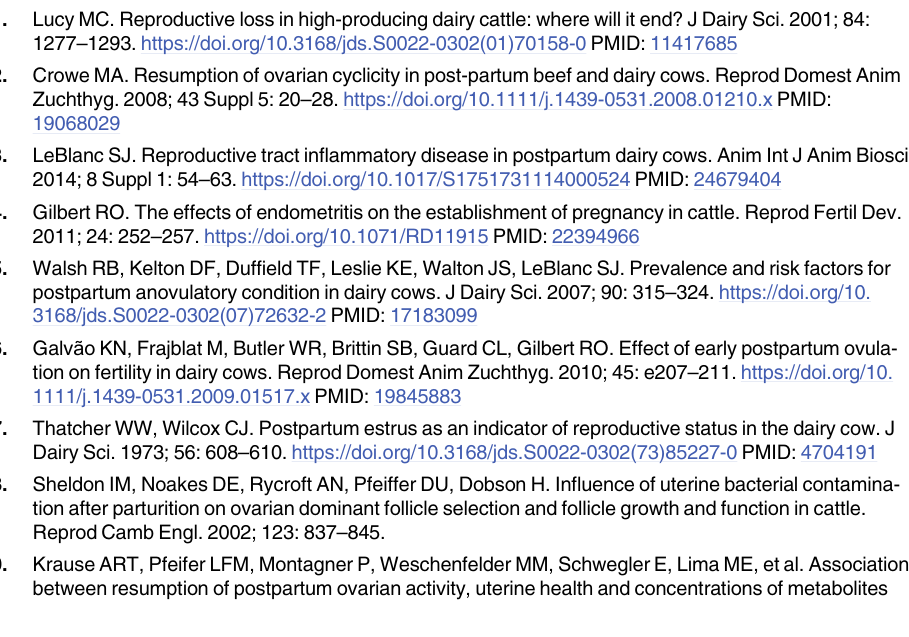
S1 Table. Table of logistic regression results for the association between covariates with follicular